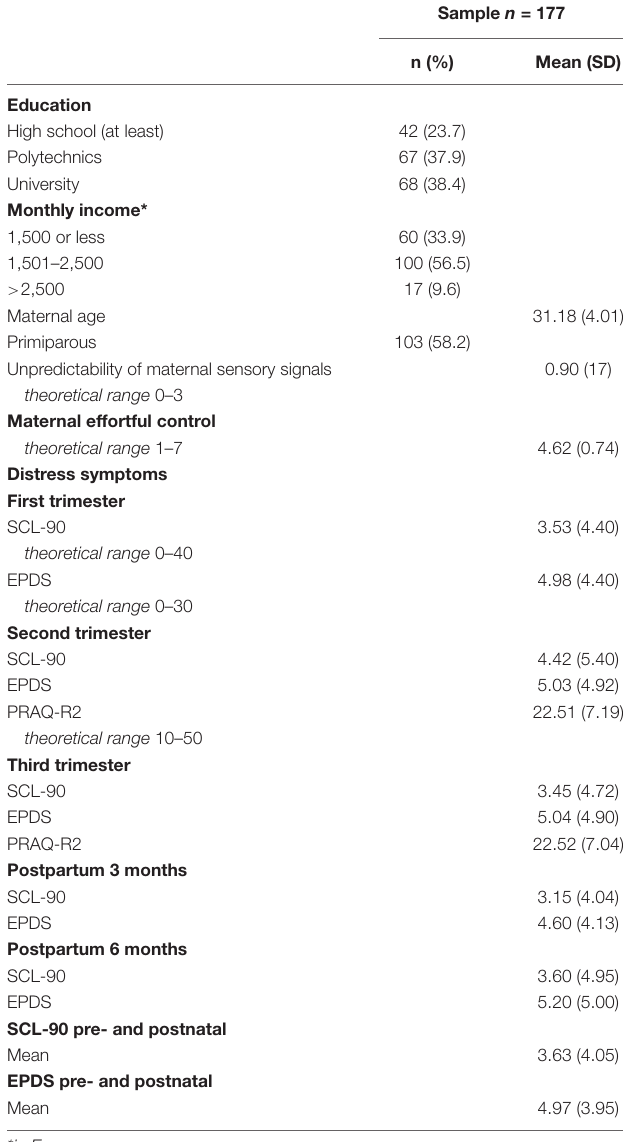
TABLE 3 | Sample characteristics ( n =